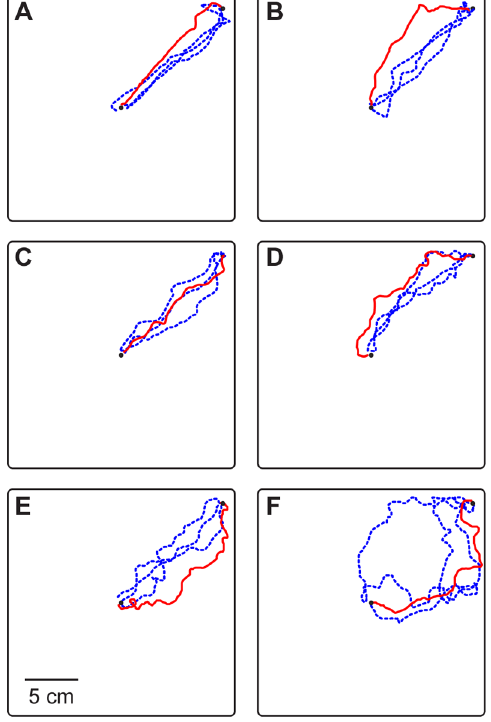
Figure 3. Sample paths before and after substrate rotation. Each panel shows a single ant’s paths before rotation (dashed blue line) and afterwards (solid red line). Squares show the arena boundary. Small closed circles show locations of old nest entrance at arena center and new nest entrance at upper right corner.